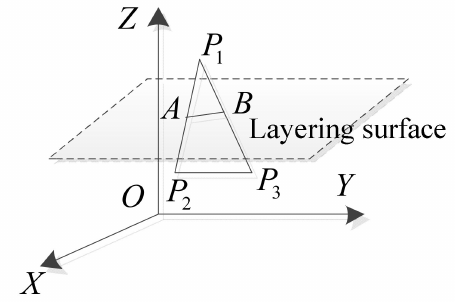
Figure 3. Schematic diagram of sliced triangular